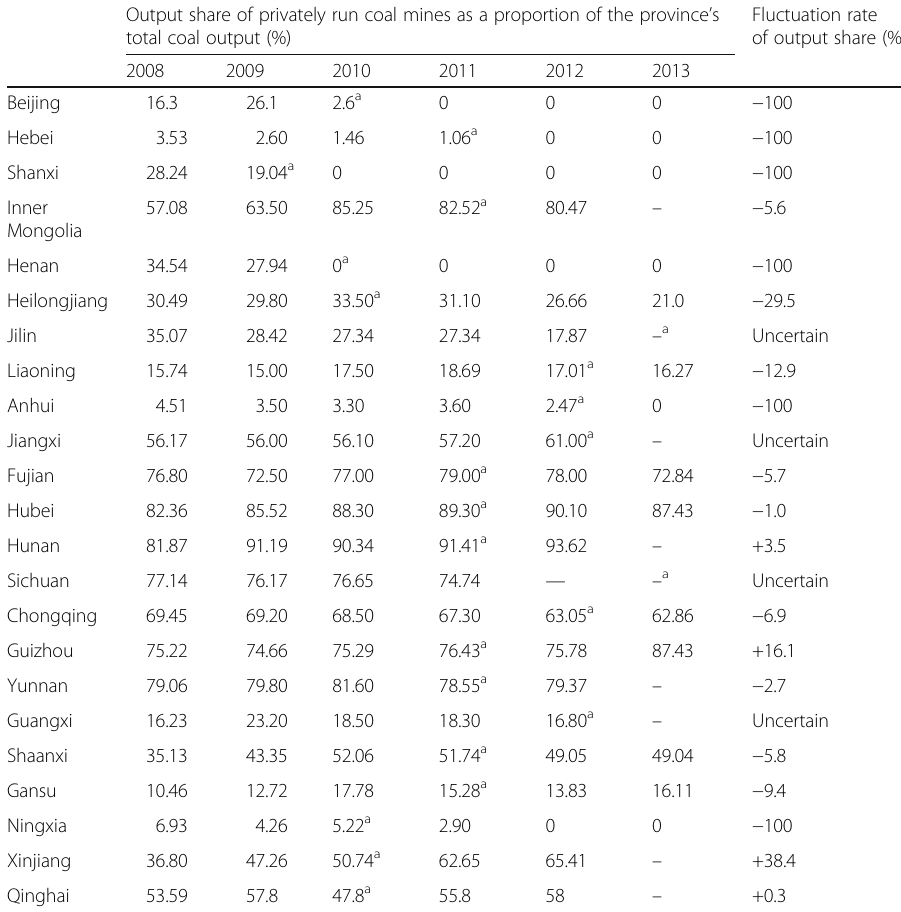
Table 1 Output share of privately run coal mines as a proportion of the province ’ s total coal output before and after the mergers and reorganizations campaign and its fluctuation rate